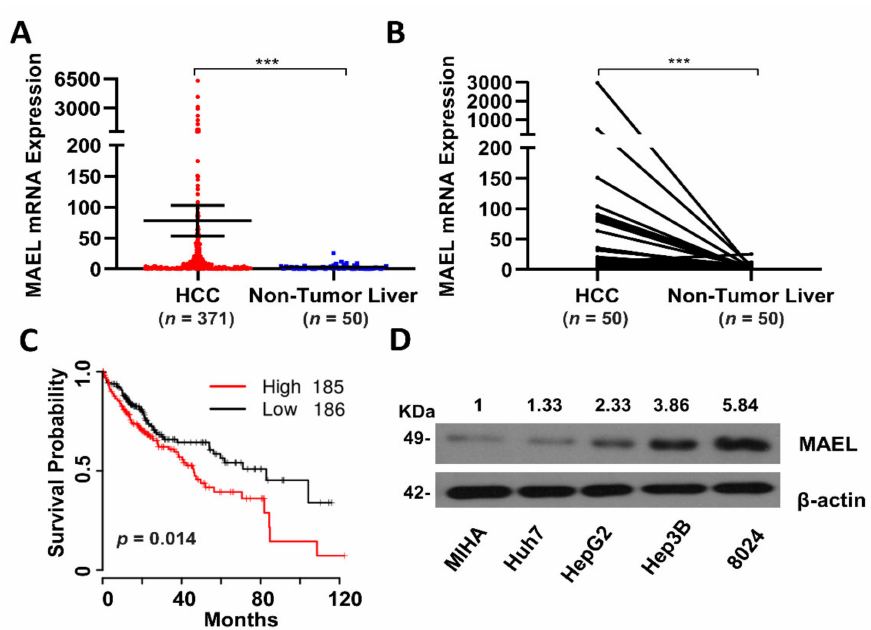
Figure 1. MAEL expression in HCC samples and cell lines. ( A ) The mRNA expression of MAEL analyzed from 371 HCC tissues and 50 non-tumor tissues in the TCGA database. ( B ) The mRNA expression of MAEL in 50 HCC tissues and matched adjacent non-tumor tissues analyzed in the TCGA database. ( C ) Kaplan–Meier plot for overall survival of high ( n = 185) and low MAEL ( n = 186) expression groups (50% cut off) in the TCGA database. p = 0.014. ( D ) Western blots of MAEL expression in HCC cell lines. Full Western Blot can be found in Figure S5. *** p <